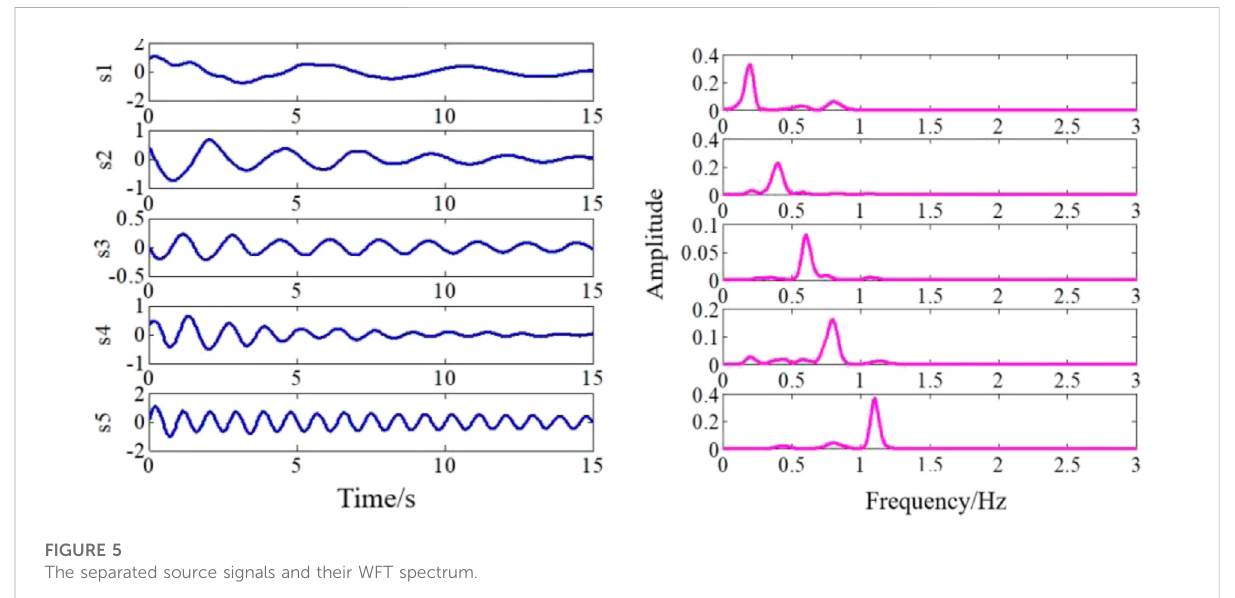
FIGURE 5 The separated source signals and their WFT spectrum.